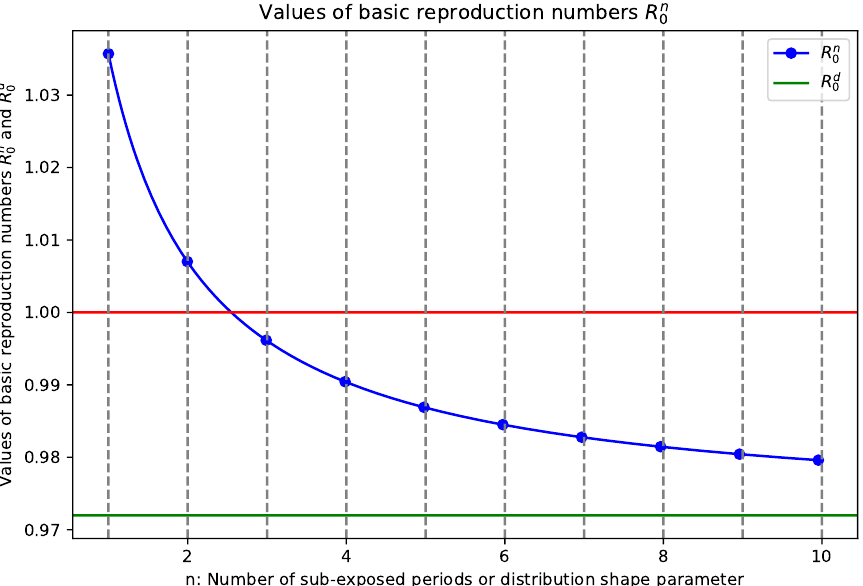
n: Number of sub-exposed periods or distribution shape = 1.45, δ = 0.5 and γ = 0.2. Different values of R n Figure 3. Parameters are β E γ I n = 1,2,3, · · · . The function R n (blue curve with dots) is decreasing as n increases, and the limit is 0 R d (green horizontal line) with n → ∞ . The red horizontal line is the threshold value 1. It is noticed 0 that R n is not a continuous function, but a function with the range Z 0